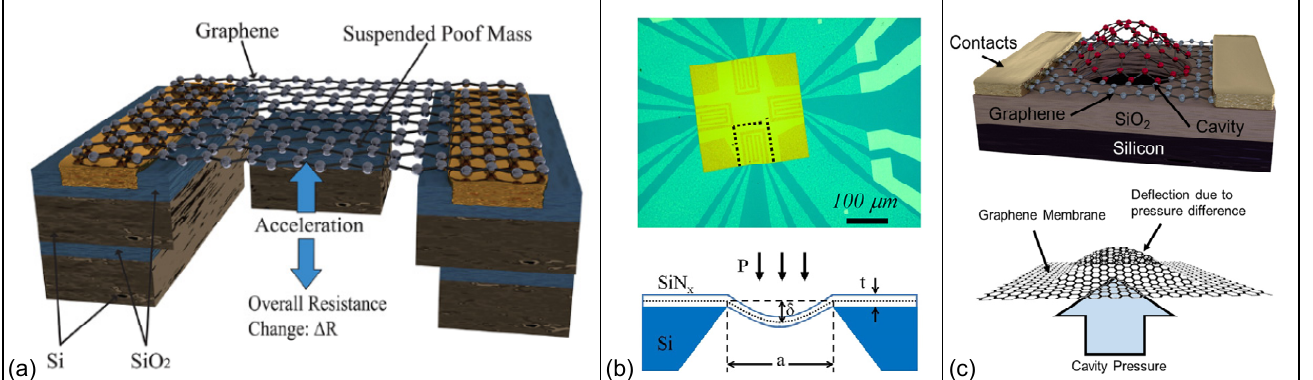
Figure 9. ( a ) 3D design of an accelerometer with a suspended graphene ribbons and an attached proof mass [202] . ( b ) 1-Optical microscope image of graphene piezoresistors on silicon nitride membrane and the schematic of suspended silicon nitride layer under the applied differential pressure. Reprinted with permission from ref. [23]. Copyright (2013) AIP Publishing. ( c ) Schematic of a suspended graphene cover a circular cavity to measure the chamber pressure due to pressure difference [64] .